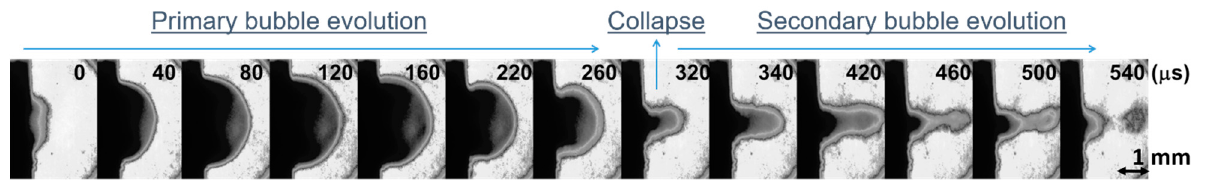
Figure 6. ( a ) Sketch of the experimental set-up for temporally resolved shadowgraph images. ( b ) Sketch of cavitation bubble where Ry is employed to determine the bubble radius, Rx is employed to determine the bubble front expansion. (The z and x axes are the shadowgraph and laser direction, respectively).